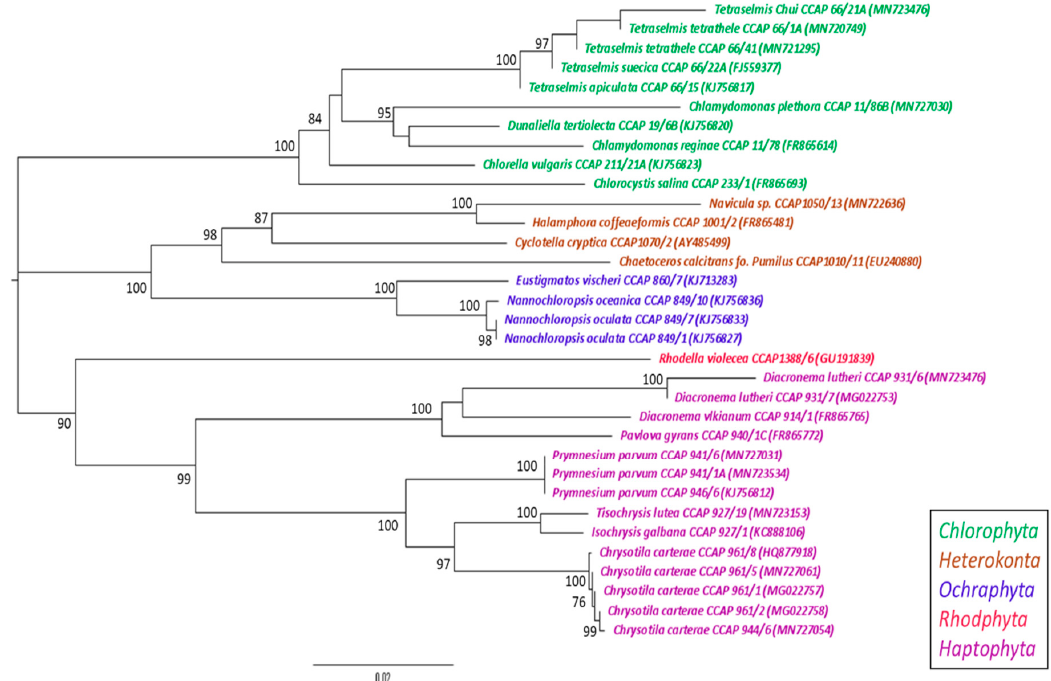
Figure 1. Nearest Neighbour-Joining phylogenetic tree of 18S rRNA microalgal genes. Taxa colouring represents the phyla; green, Chlorophyta; brown, Heterokonta; blue, Ochrophyta; red, Rhodophyta; purple, Haptophyta. Bootstrap values above 70% are indicated on the branches.